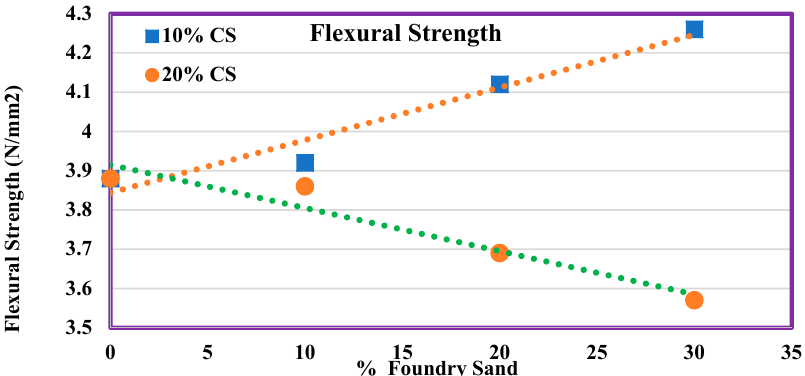
Figure 10. Flexural strength of concrete contains various ratios of FS as well as CS.